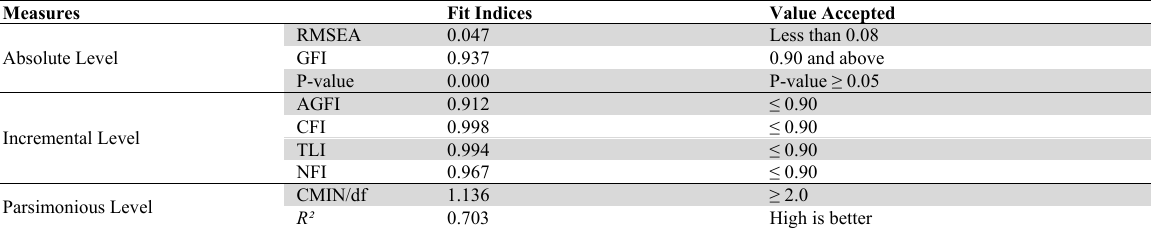
Goodness of fit of the hypothesized model